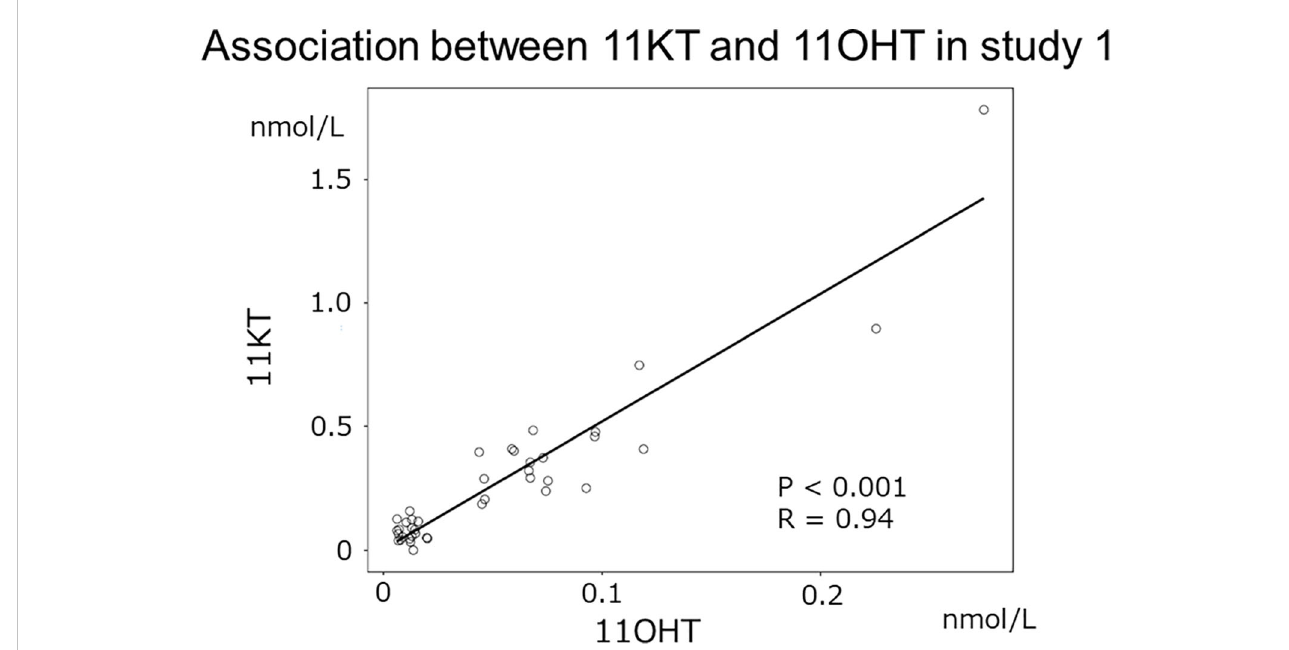
FIGURE 3 Association between 11KT and 11OHT in study 1. The scatter plot shows the association between 11KT and 11OHT in study 1 (Pearson ’ s correlation coef fi cient: 0.94 [P <